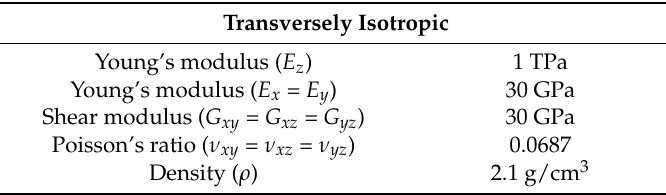
Figure 5. A schematic of the equivalent fiber model. Table 2. Mechanical properties of multiwalled carbon nanotube [49,50].